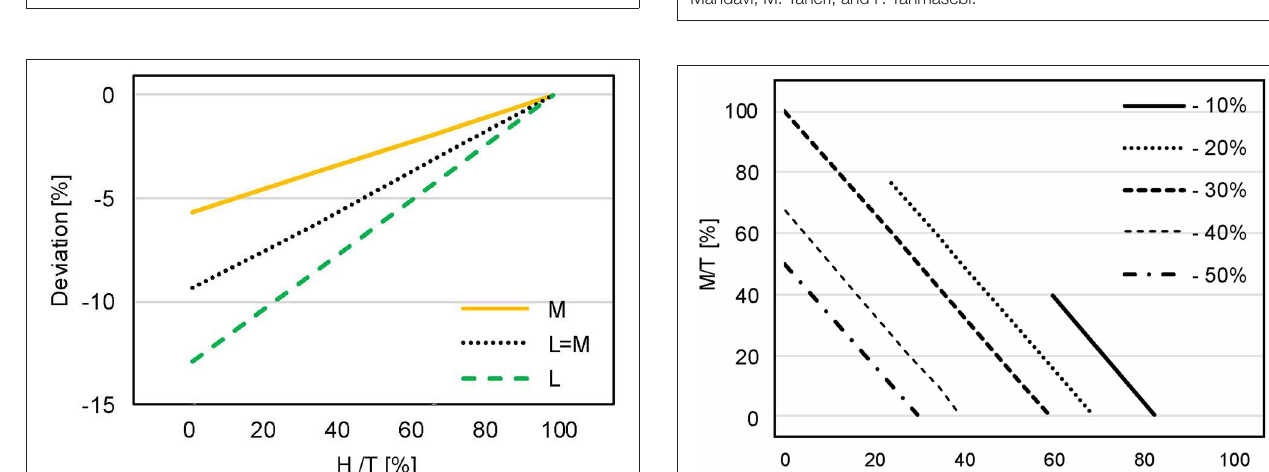
FIGURE 3 | Lines of equal deviation (from − 5 to − 20%) of the annual heating demand from the benchmark, depending on the fraction of H, and M in total population. Reproduced from Mahdavi et al. (2018) with permission from A. Mahdavi, M. Taheri, and F. Tahmasebi.